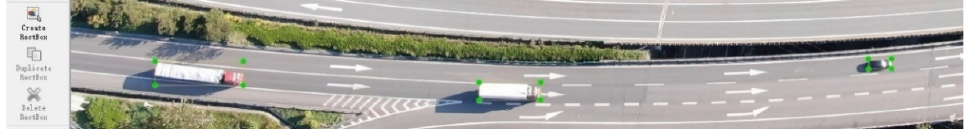
Figure 8. Labeling vehicles for training.